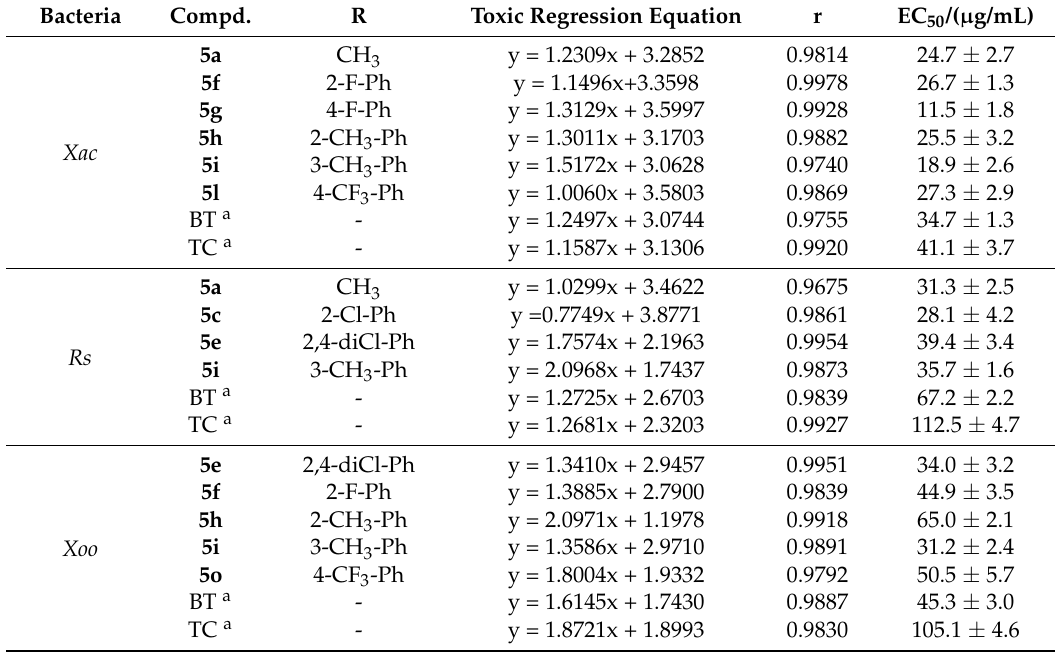
Table 2. EC 50 values of the title compounds against plant pathogenic bacteria in vitro. Bacteria